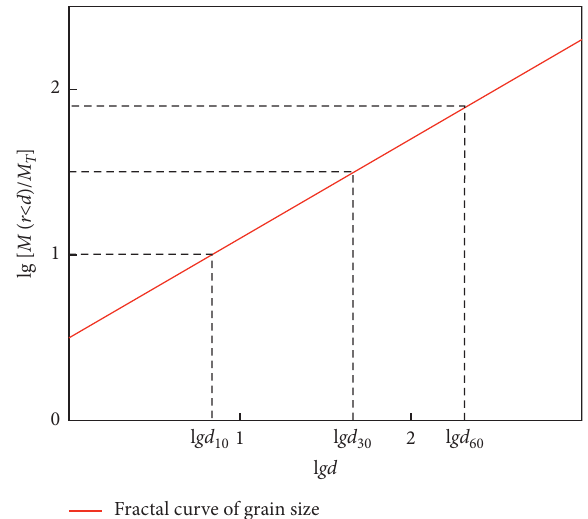
Figure 15: Particle size fractal distribution curve of recycled ag- gregate with fractal structure.